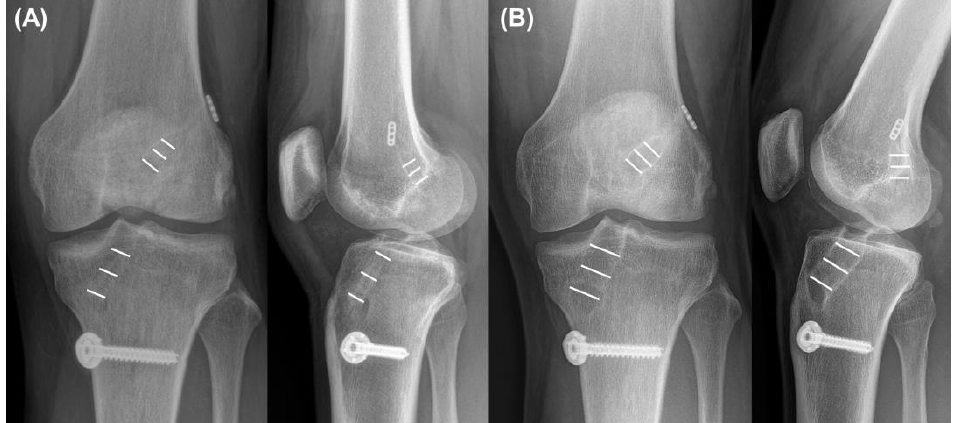
Figure 4. Measurement of ( A ) immediate and ( B ) 2-year postoperative tunnel diameters on the anteroposterior and lateral views. Tunnel widths were measured at three points on each tunnel— aperture, midpoint, and exit. Average values of each tunnel were used for analysis.